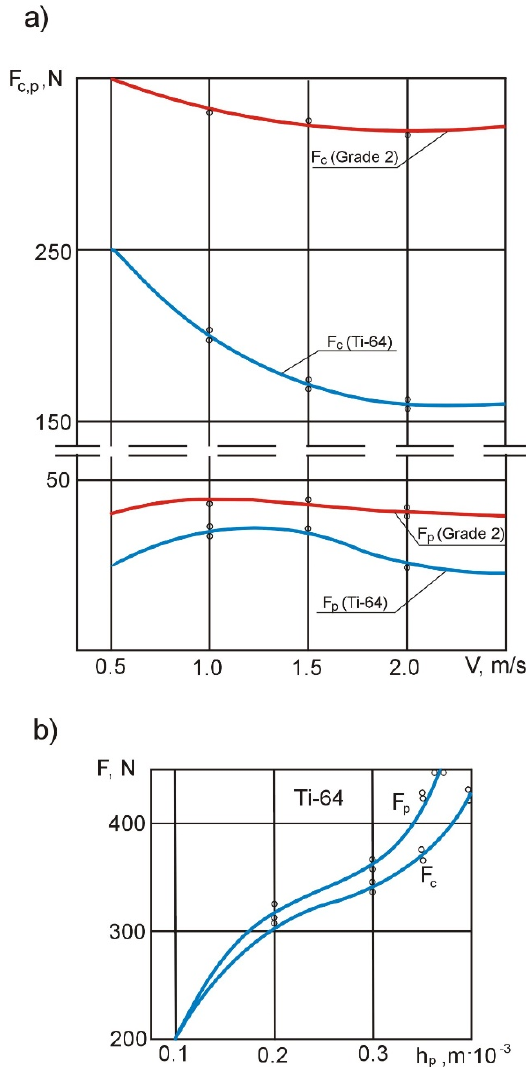
Figure 5. Curves of changes in F c and F p in the external turning operation as a function of the cutting speed ( a ) and wear h p under tension ( b ).